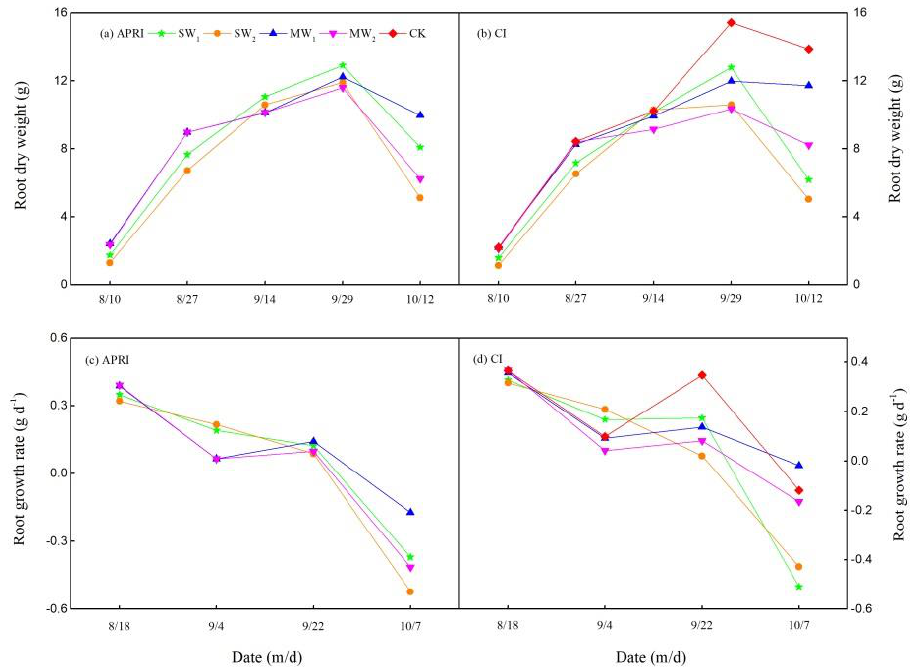
Figure 5. Root dry weight ( a , b ) and root growth rate ( c , d ) in the whole soil profile (0~50 cm) of maize in SW 1 , SW 2 , MW 1 , MW 2 , and CK treatments throughout the growing season.